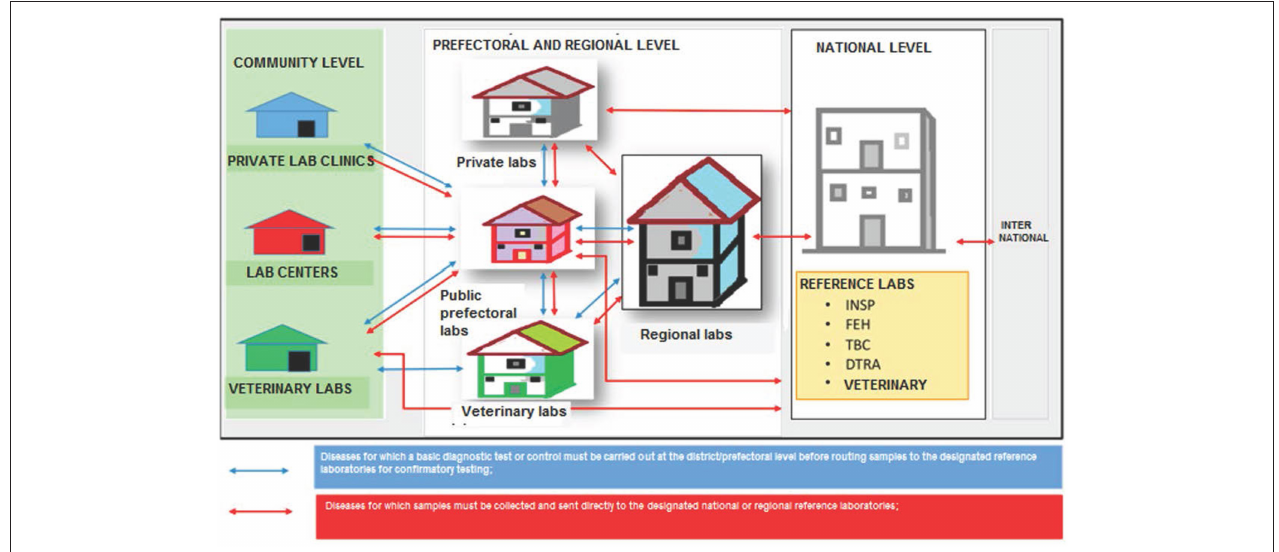
FIGURE 3 | Schematic of “star” transportation model adopted by consensus by stakeholders for referral of specimens from sub-prefectural to prefectural and regional laboratories, and up to the national level. INSP, National Public Health Institute; FEH, National Viral Hemorrhagic Fever laboratory; TBC, National Tuberculosis Reference Laboratory; DTRA, Ratoma Ebola Diagnostic